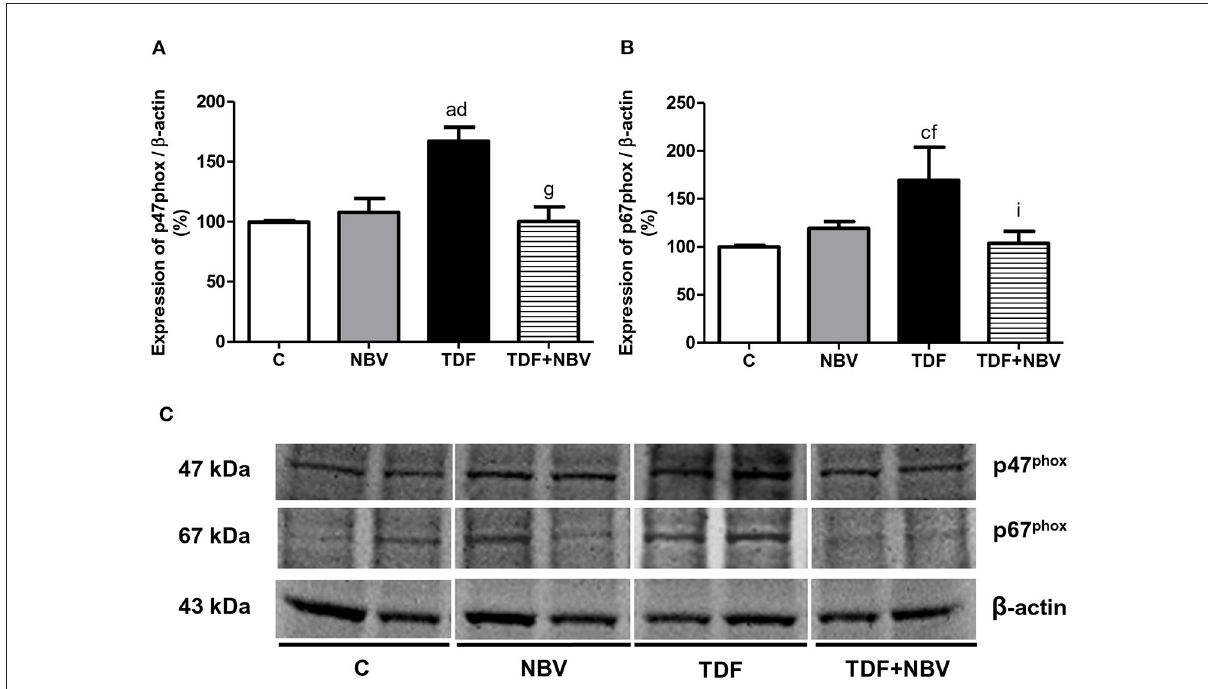
FIGURE6 Semiquantitative immunoblotting for p47 phox and p67 phox expression in rat kidney tissue. (A) p47 phox densitometric analysis of samples from C ( n = 7), NBV ( n = 7), TDF ( n = 8) and TDF + NBV ( n = 8) rats. (B) p67 phox densitometric analysis of samples from C ( n = 7), NBV ( n = 7), TDF ( n = 8) and TDF + NBV ( n = 8) rats. (C) Representative immunoblots which reacted with anti-p47 phox and anti-p67 phox revealing bands of 47 and 67kDa, respectively. Values are means ± SEM. a p < 0.001, c p < 0.05 vs. C; d p < 0.001, f p < 0.05 vs. NBV; g p < 0.001, i p < 0.05 vs. TDF. C, control; NBV, Nebivolol; TDF,